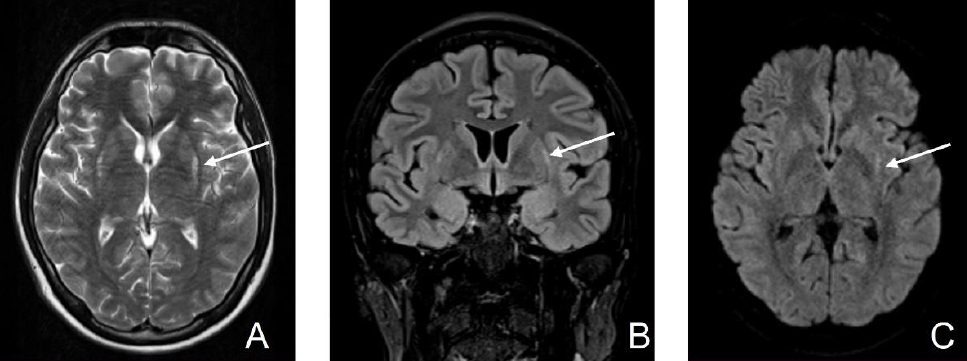
Figure 4. Fourth MRI (D45). ( A ) T2-wi sequence: limited hyper signal in bilateral putamen in the posterior external region; ( B ) Cor FLAIR image: minimal hyperintensity in the periphery of bilateral putamen; ( C ) Axial DWI: minimal restricted diffusion persistent in the periphery of bilateral putamen (white arrow).